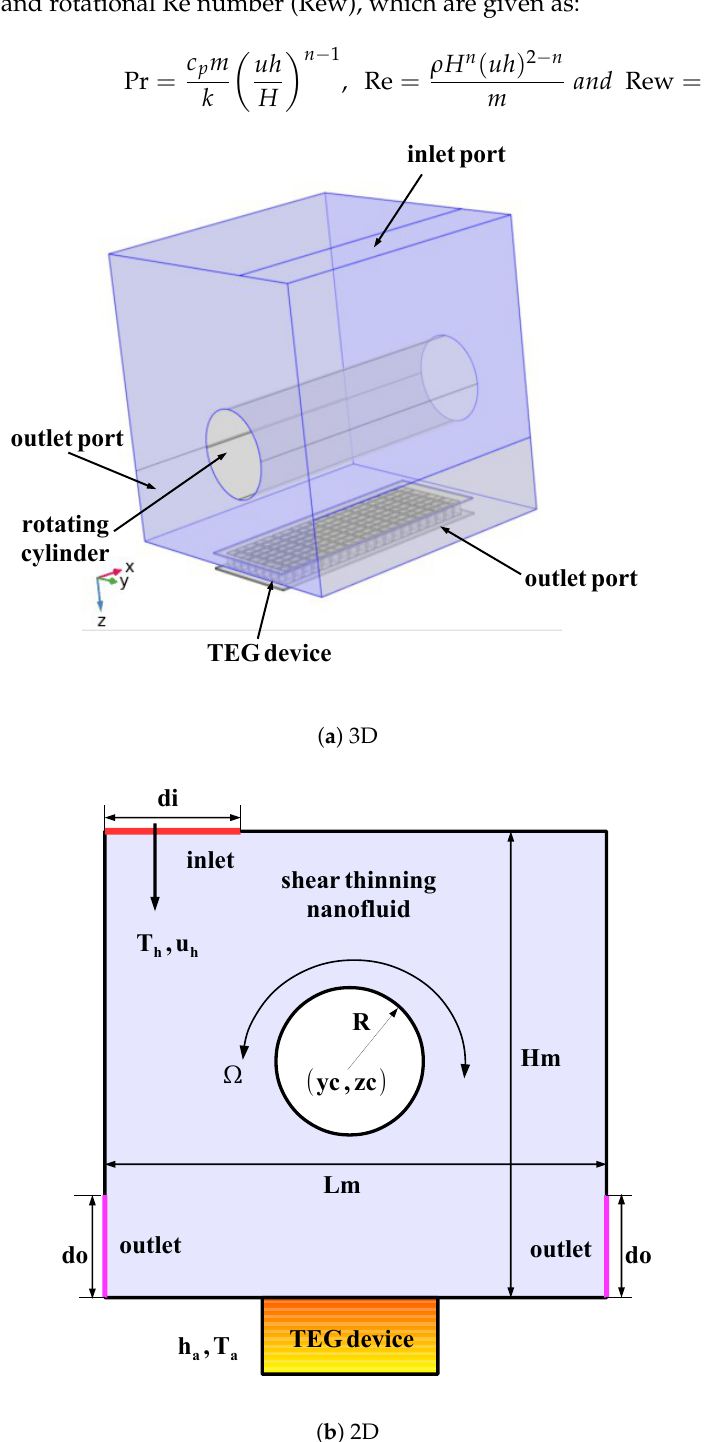
Figure 1. TEG-installed VC using a rotating cylinder and shear thinning nanofluid in 3D ( a ) and 2D view with dimensions ( b